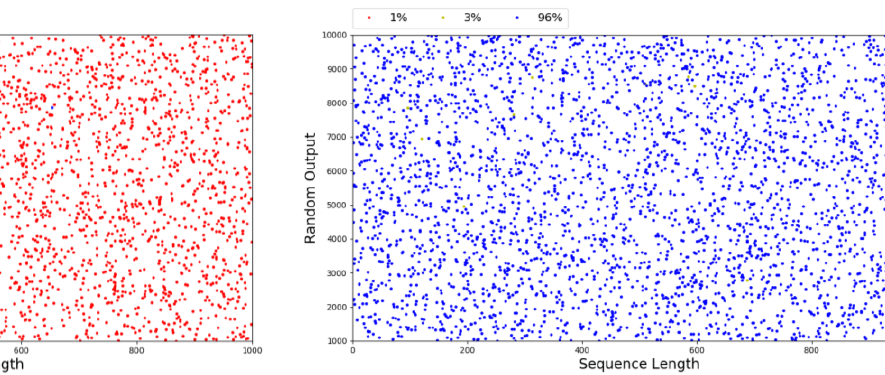
Fig. 15. Random number generation output frequency scatter plot with audio seed, post-optimisation with no noise